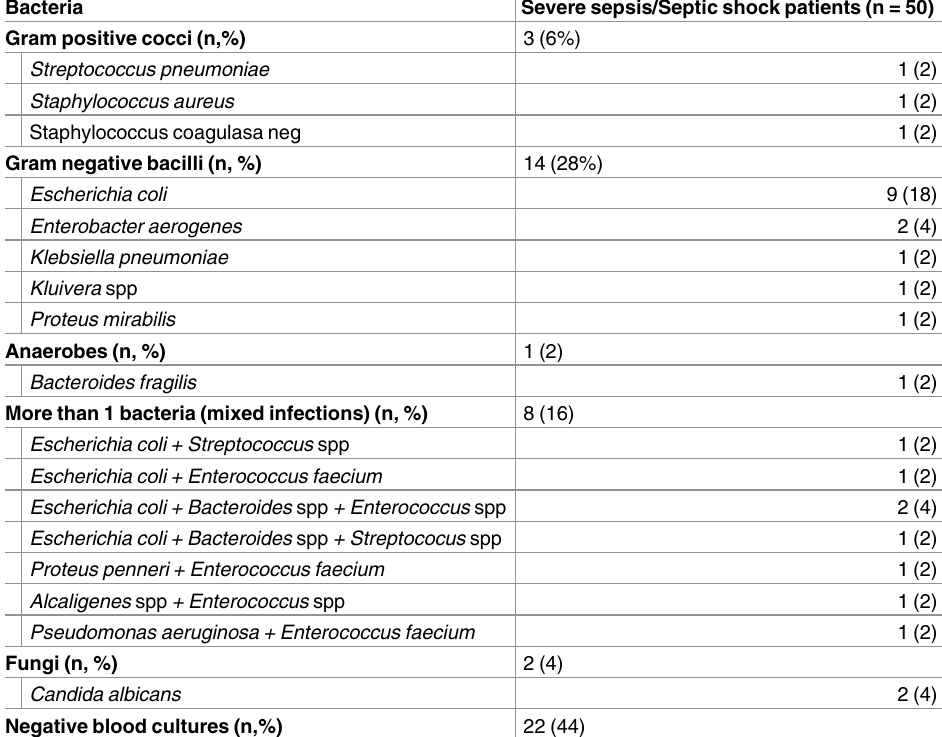
Table 4. Bacteriaisolated in blood cultures of patients with severesepsis/septic shock. Bacteria Severe sepsis/Septic shock patients (n = 50) Gram positive cocci (n,%) 3 (6%)